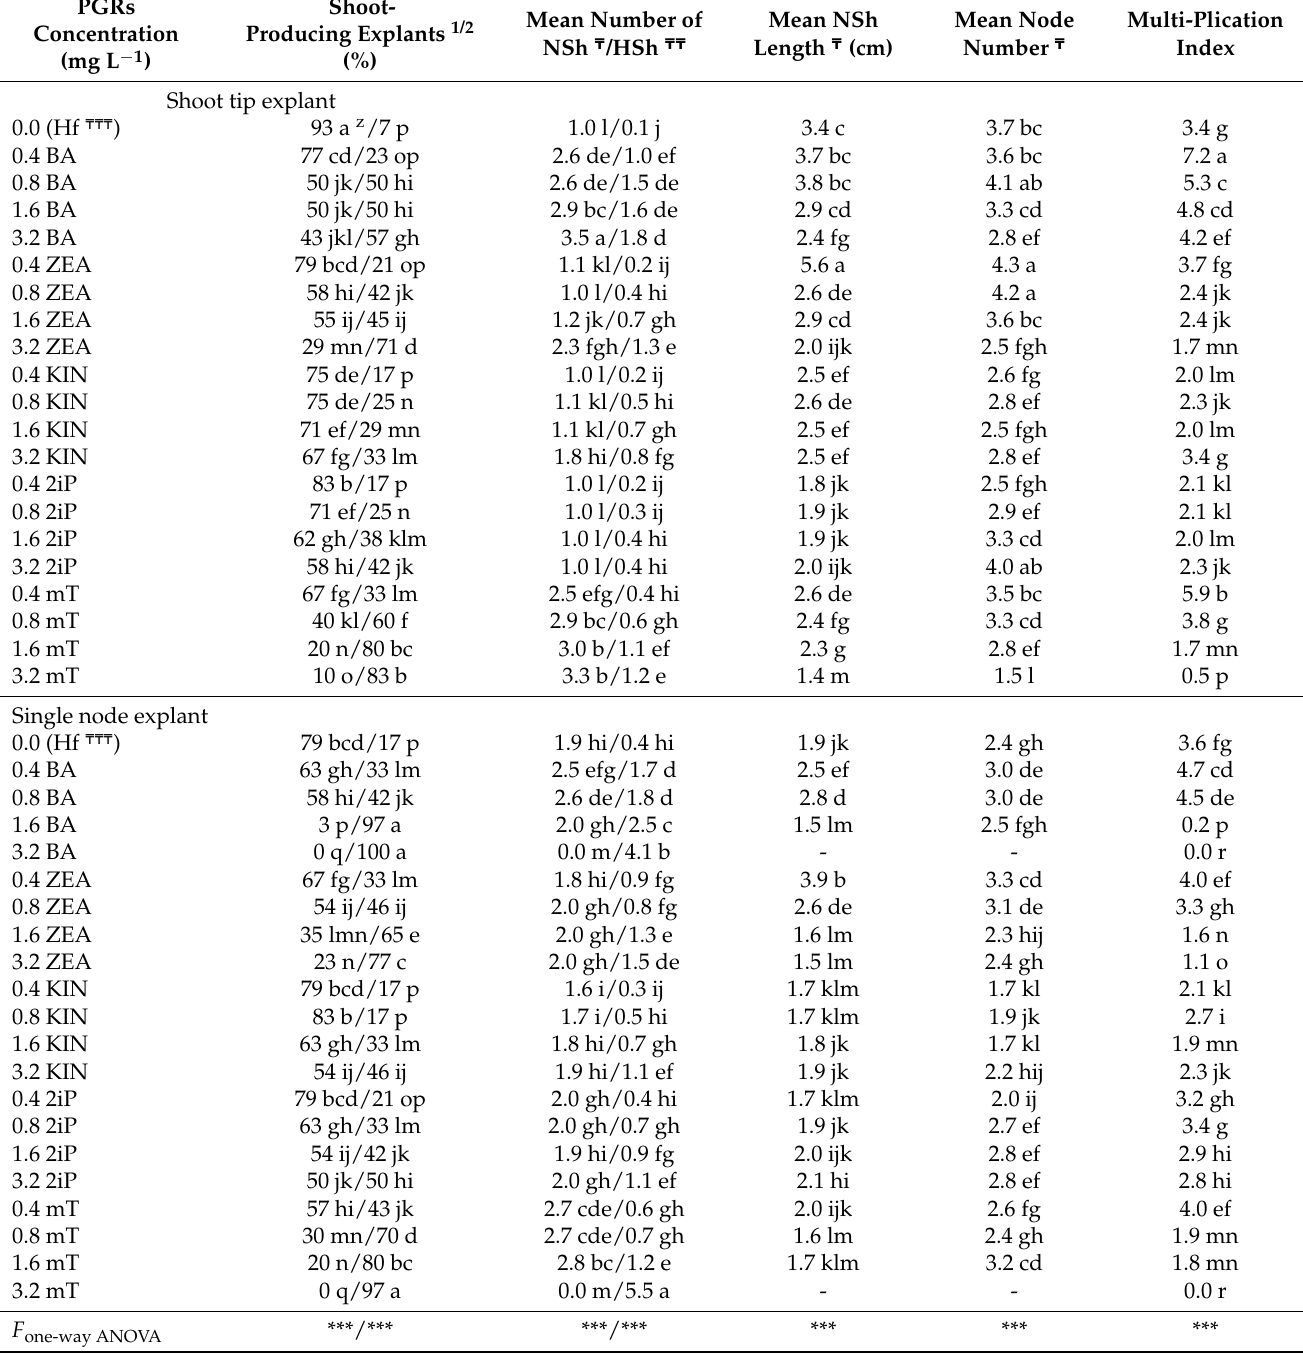
Table 1. Effect of Salvia species and explant type on axillary shoot production of explants excised from in vitro seedlings of Greek sage species, at the establishment stage of in vitro cultures on a hormone-free MS medium.